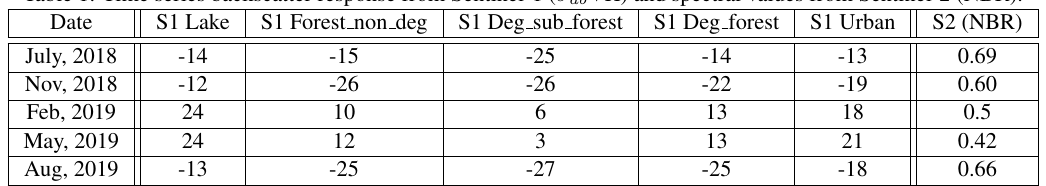
Figure 3: Spectral indices on Sentinel-2 (10/08/2019): Left (from left to right): NBR, NBR − NDWI, NDWI, and color scale. Right: S2 MSI natural image (with spectral bands 12, 11 and 8A). Table 1: Time series backscatter response from Sentinel-1 ( σ db VH) and spectral values from Sentinel-2 (NBR).